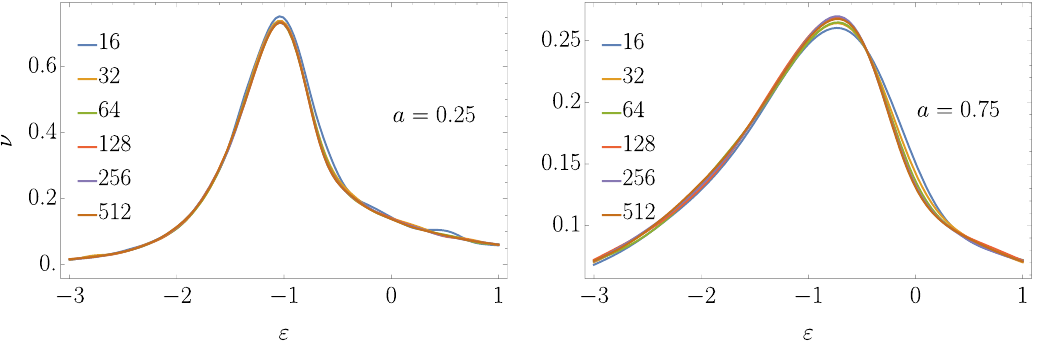
Figure 5: Density of states for several cutoffs averaged over 10 3 realizations. All plots show that DOS saturates at very small cuttoff values R (shown in the legend) and it is a non-singular